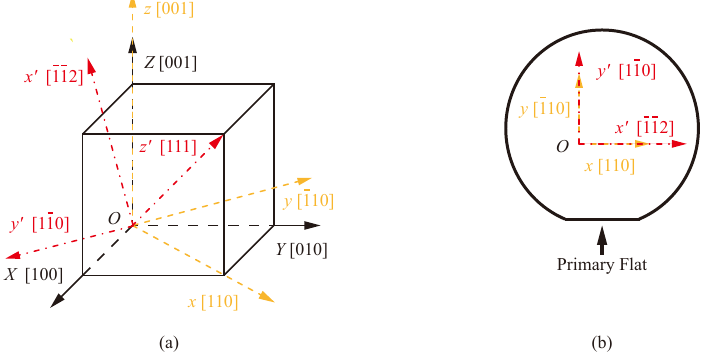
Figure 1. Coordinate systems and overhead views of the (100) and (111) silicon wafers: ( a ) Coordinate systems of two wafers, ( b ) Overhead views of two